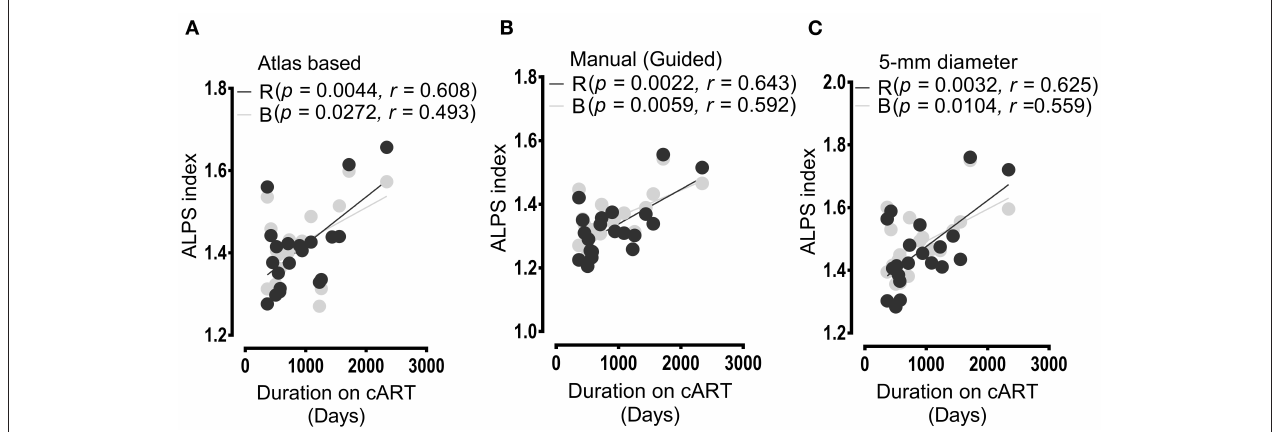
FIGURE 5 | Results of correlations between the duration of cART treatment and ALPS index. In all analyses (A,B), the duration of cART treatment correlated positively with the ALPS index of the right (R) and bilateral (B) PVSs. (A) Correlation outcomes as evaluated between the cART period and ALPS index computed within the areas defined by JHU-ICBM atlas-based ROIs. (B) Correlations as assessed between ALPS index calculated within areas determined by manual DTI-guided ROIs and duration of cART treatment. (C) Correlation outcome of the duration of therapy and ALPS index measured within areas of 5-mm diameter. All correlation results were significant at p < 0.05. In the figure legend, R, right; B,